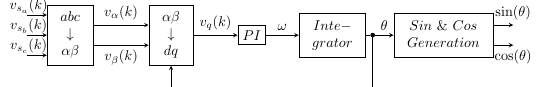
Figure 20. Three-phase